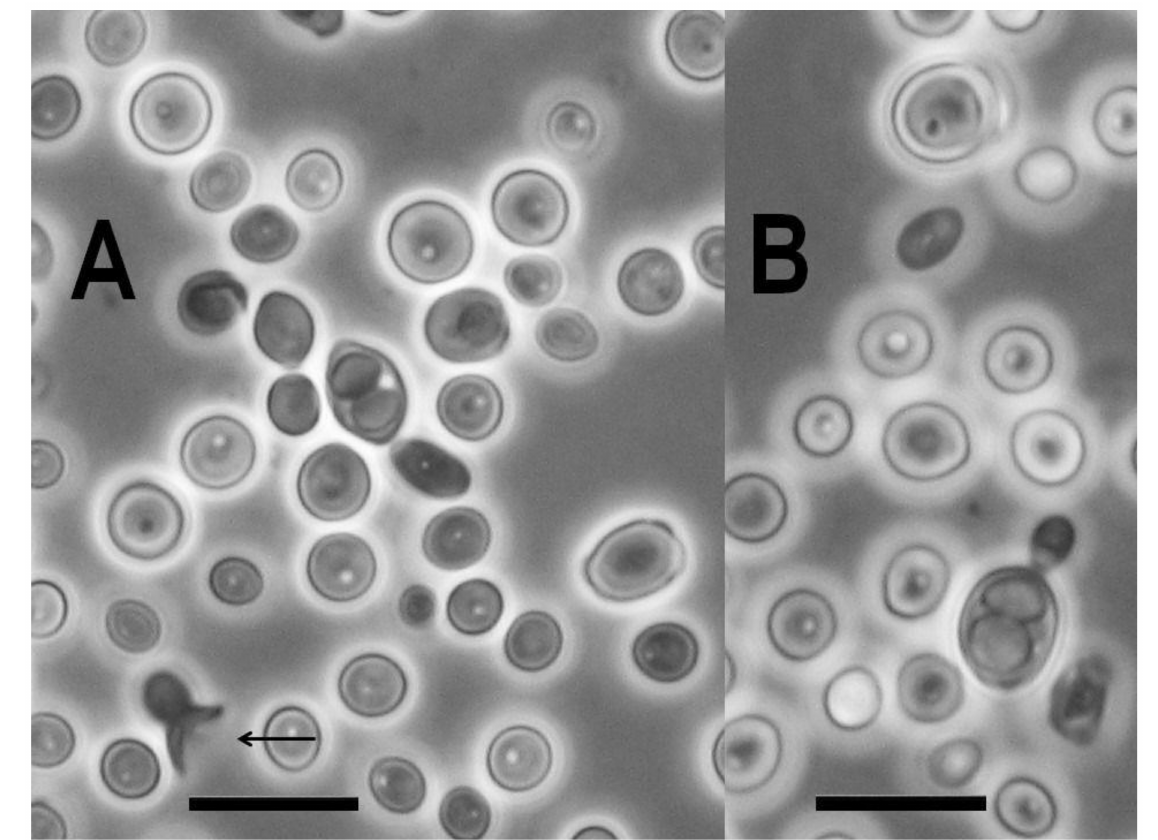
Figure 5. Ascosporulating culture of Novakomyces olei NCAIM Y.02187 T . One two-spored ascus is shown in each panel. In panel ( A ), the remnant of an ascus formed by the conjugation of the mother cell and its bud is indicated by arrow. Bar, 10 µ m for both panels ( A , B ).